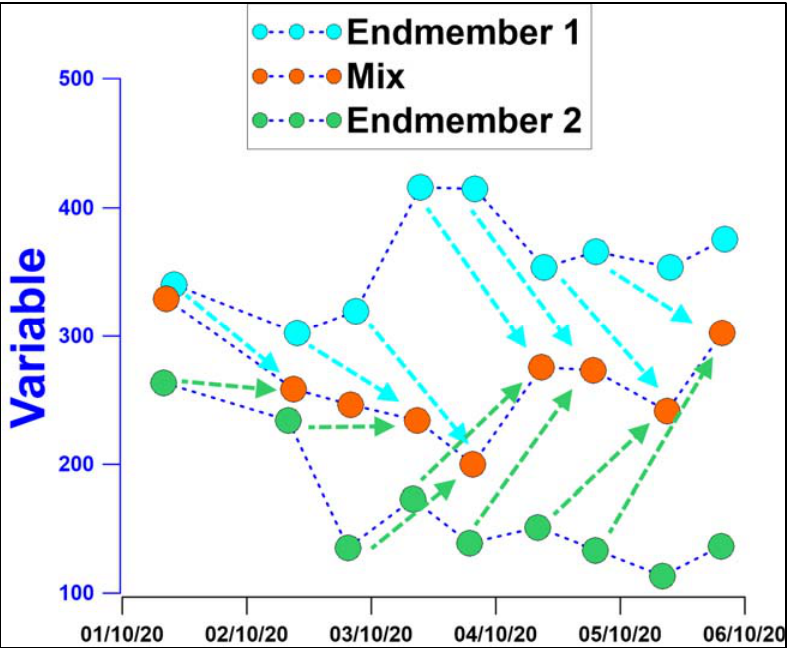
Figure 3. Illustration of how the mobile source mixing model works: the arrows represent an example of time lag of 1.5 day at which the water mass might transfer from all endmembers to the mix.